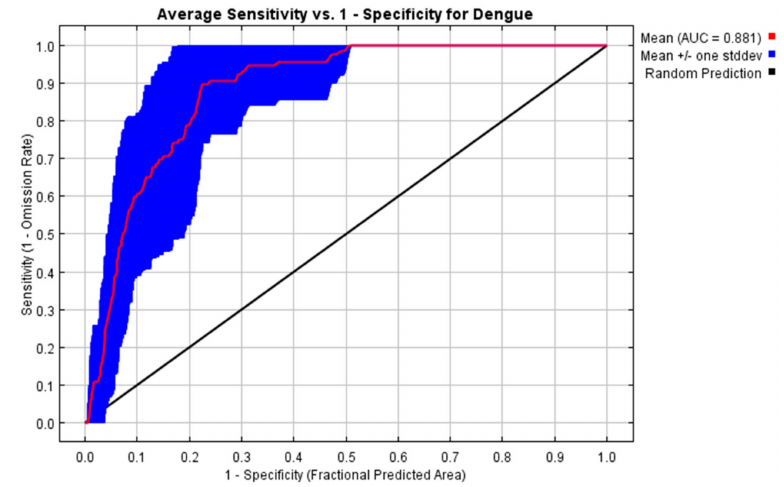
Figure 2. Average area under curve (AUC) for 30 replicates MaxEnt run. The red line is the average value and the blue bar represents plus and minus one standard deviation.